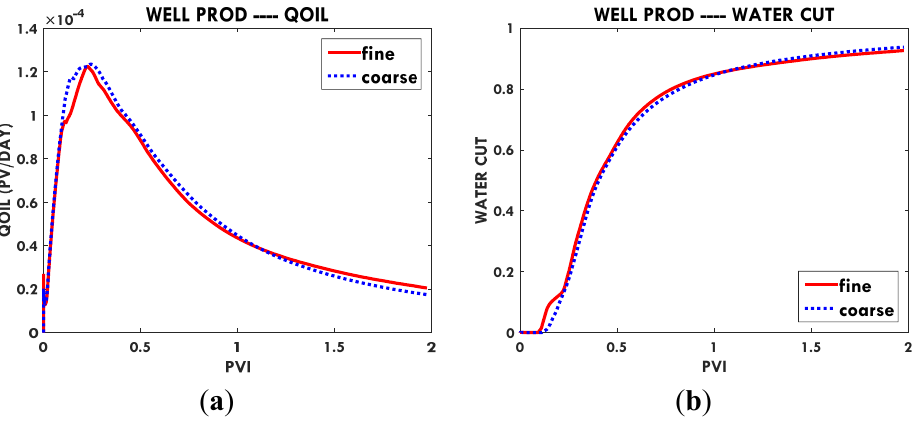
Figure 17. ( a ) Oil rate and ( b ) water cut of production well for case